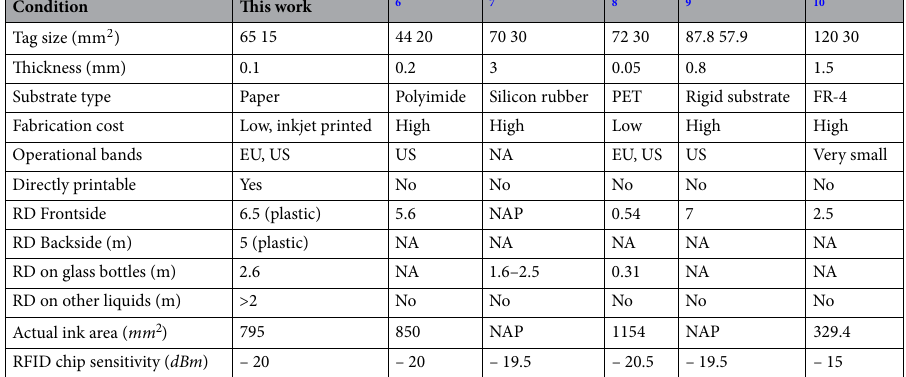
a b Read range (RD), NA stands for Not